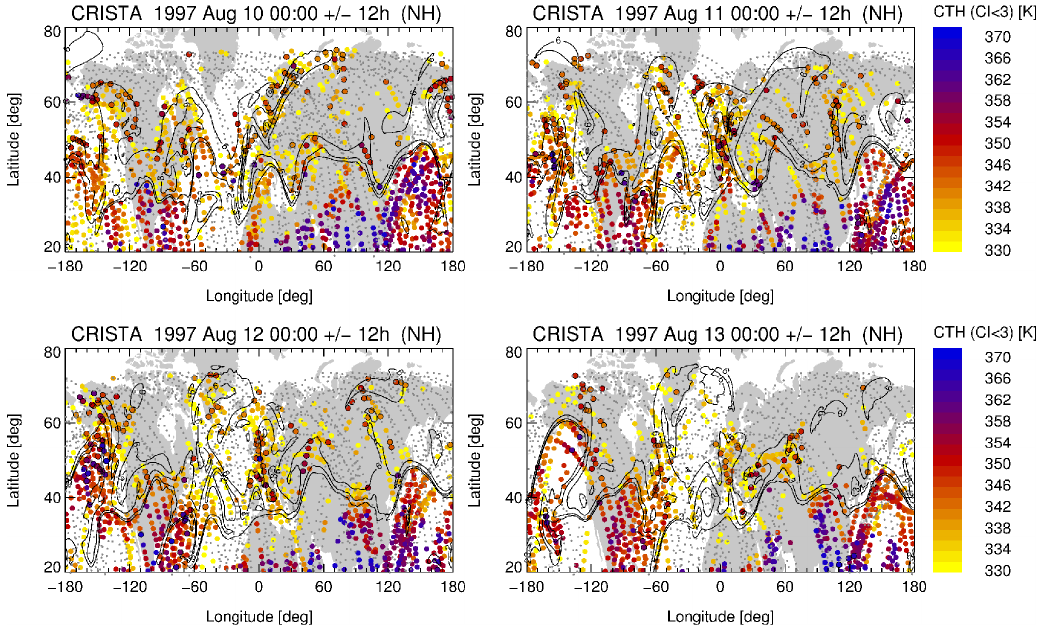
Figure 5. CRISTA-2 daily detection of cloud top heights on vertical (cid:50) -coordinates between 330 and 370 K (colour coded) from 10 to 13 August at 00:00 UTC ± 12h. Black circles around the coloured symbols mark CTH observation above the local tropopause. Potential vorticity contours for 2, 3, and 6 PVU are overlaid in black at midnight conditions. In addition, horizontal wind contours for 30 and 40ms − 1 (in green) highlight the subtropical jet as well as regions with fast horizontal transport at higher latitudes. Crosses mark non-cloudy profiles in the (cid:50) -range of 330 to 370K.